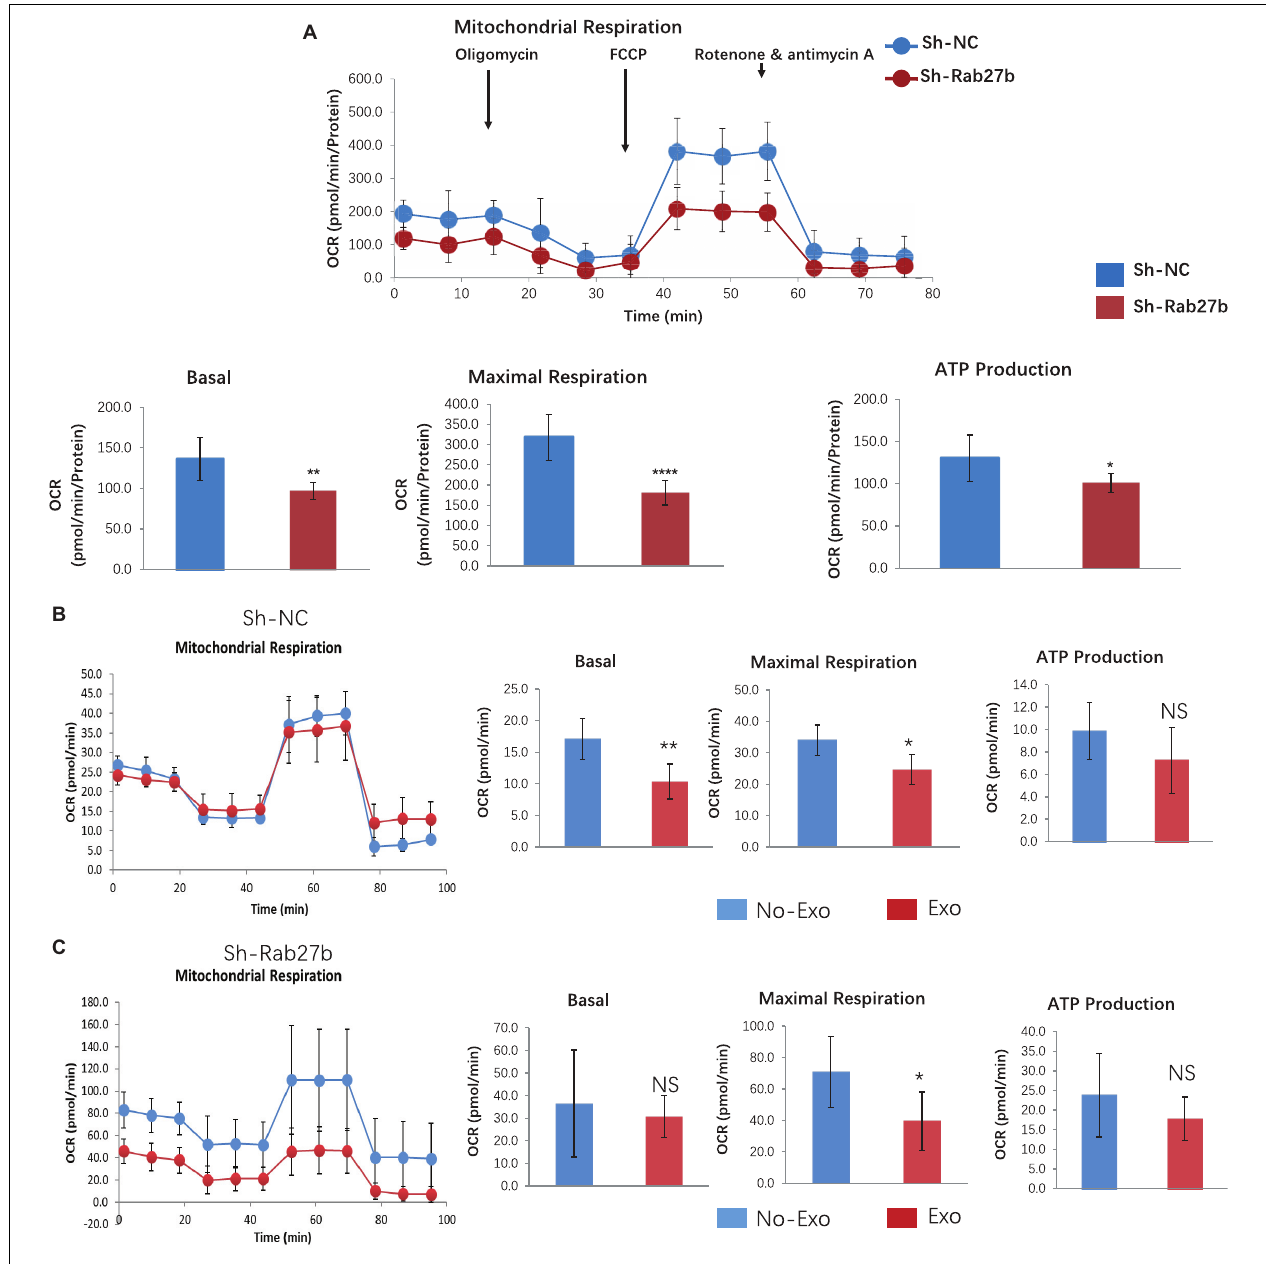
FIGURE 4 | Assessment of oxygen consumption rate (OCR) in C-MSC sh − NC and C-MSC sh − Rab27b . (A) Cells were exposed sequentially to oligomycin, FCCP, and rotenone/antimycin A. Vertical lines indicate time of addition of mitochondrial inhibitors. Oxygen consumption rate was measured over time using a Seahorse XFe96 Analyzer. Cell mito stress test was performed according to manufacturer’s protocol, results are normalized to total cellular protein ( n = 7–8). (B) C-MSC sh − NC were seeded in media with Exo-depleted FBS overnight, and primed cells with 25- µ g exosomes from wild-type C-MSC for 1 h before OCR assay using a Seahorse